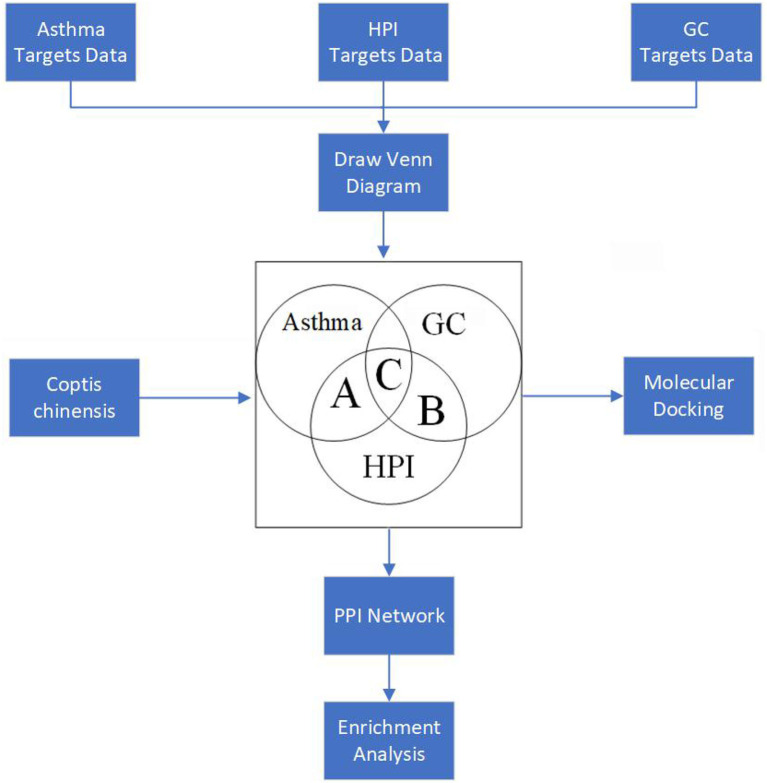
Flowchart of the experimental process (HPI, Helicobacter pylori infection; GC, gastric cancinoma; PPI, protein–protein interaction).